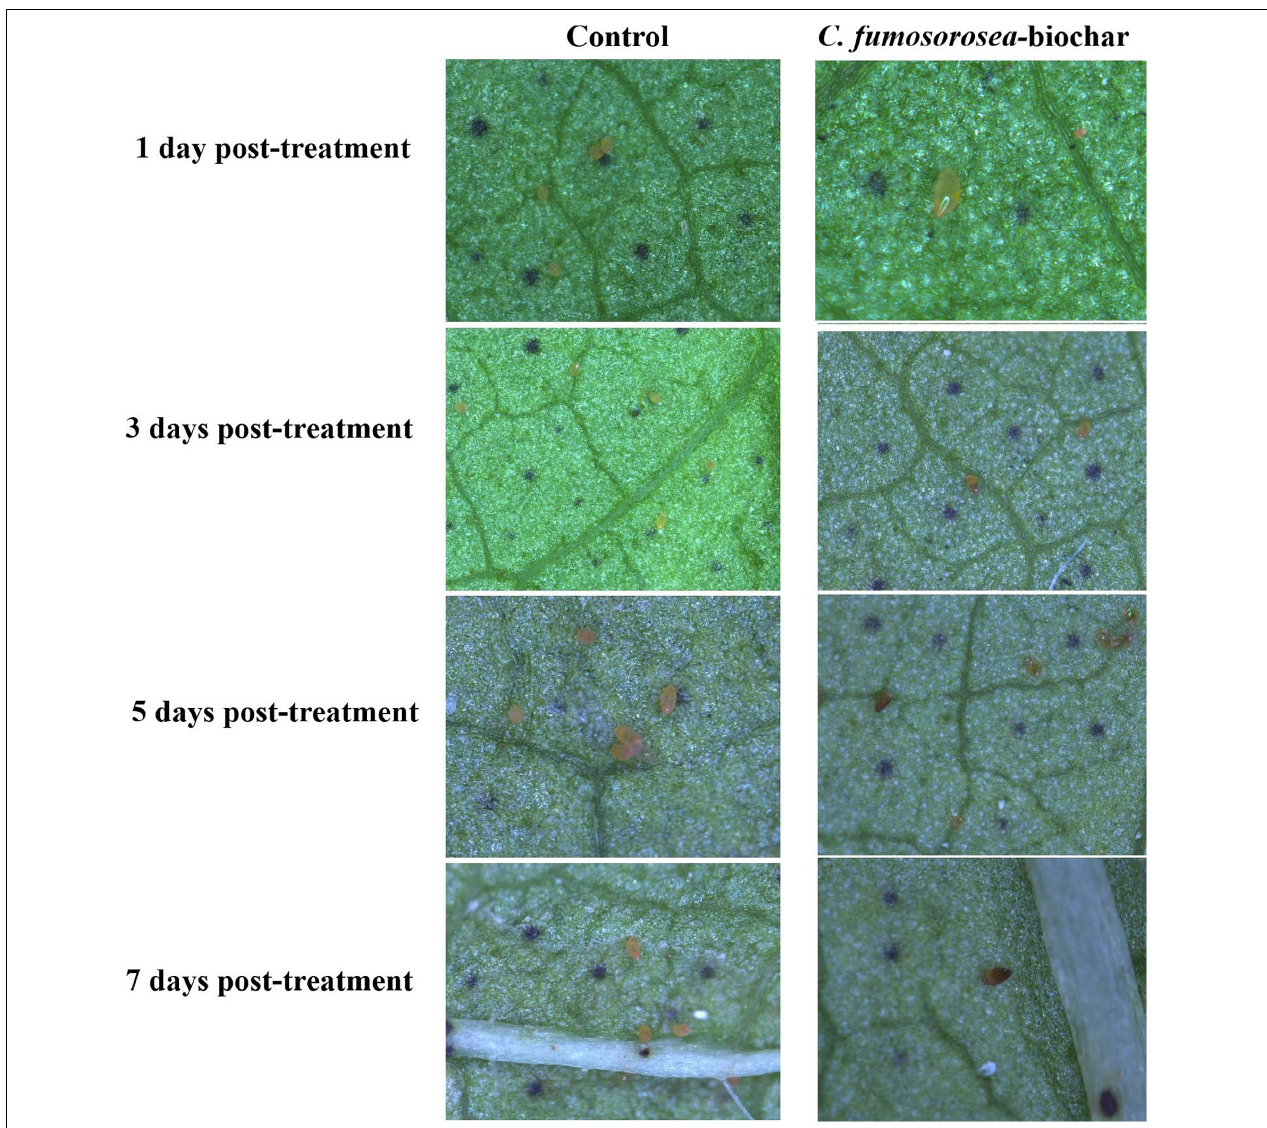
FIGURE 9 | Microscopic explanation of Bemisia tabaci egg infection by Cordyceps fumosorosea -biochar nanoparticles.